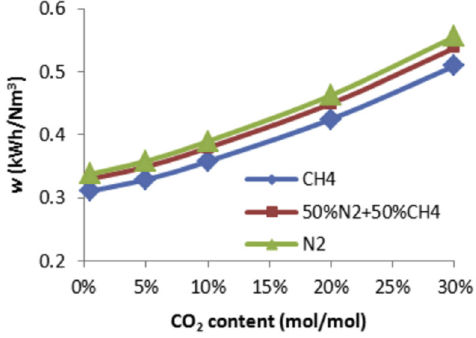
Reproduced with permission from Elsevier (license number 5413470366827). Figure 58. The proposed process without precooling [208].